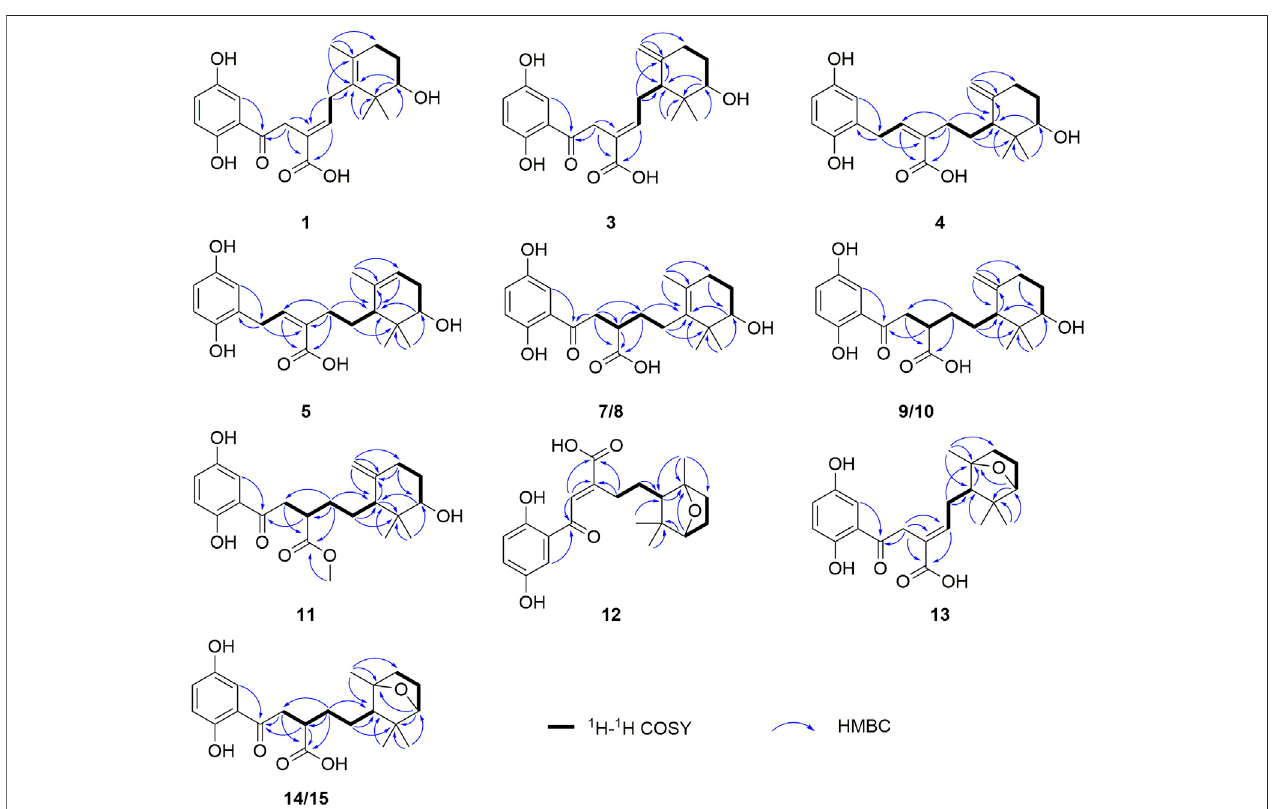
FIGURE 2 | Key COSY and HMBC correlations of 1 , 3 – 5 , 7 – 15 .